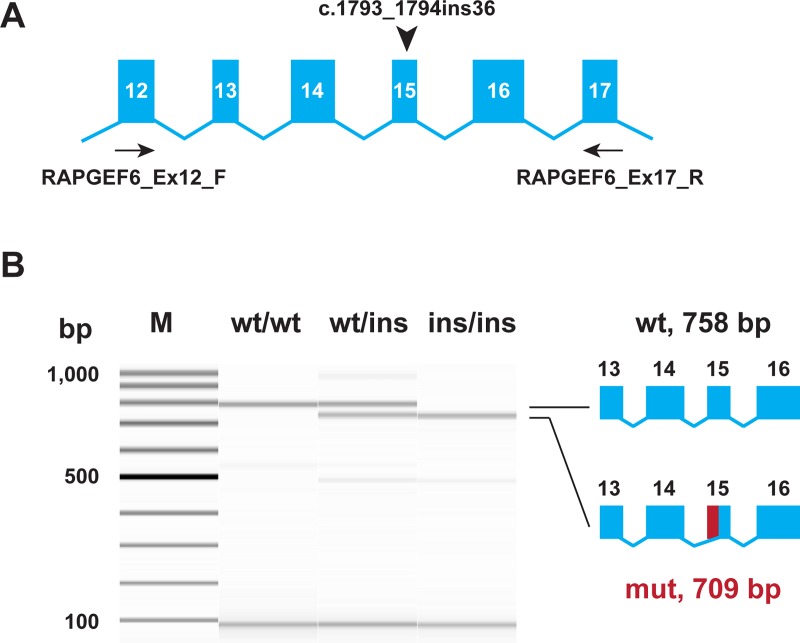
Experimental verification of the RAPGEF6 splice defect.(A) The genomic organization of the RAPGEF6 gene in the region of exon 15, position of the insertion, and position of primers for RT-PCR are indicated. (B) RT-PCR was performed with RNA isolated from blood samples of dogs with the three different genotypes. The picture shows a FragmentAnalyzer gel image of the experiment. In the control animal, only the expected 758 bp product is visible. In an LP affected dog homozygous for the insertion, a 709 bp product representing a transcript lacking 49 nucleotides is visible. The genomic insertion leads to the use of an aberrant internal splice acceptor site and a transcript lacking the 5’-end of exon 15 (RAPGEF6:r.1732_1780del). The identity of the bands was verified by Sanger sequencing.